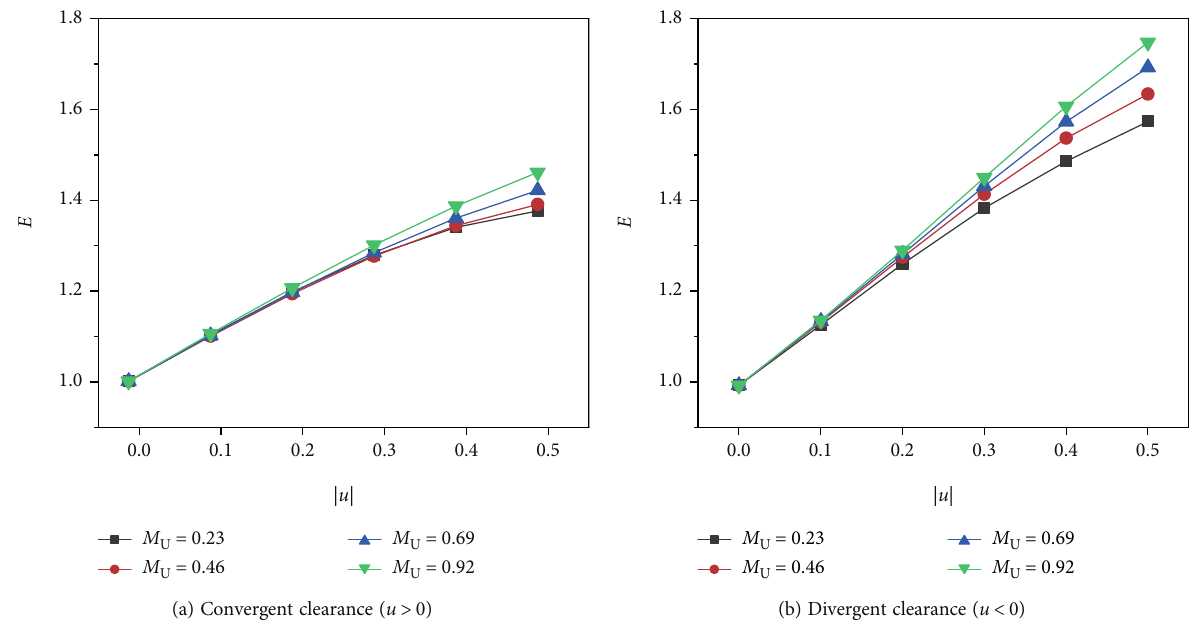
Figure 20: Variations of nonuniformity impact factor under di ff erent circumferential Mach numbers ( Re = 10000 , π = 1 : 1 , and C = 0 : 067 ).